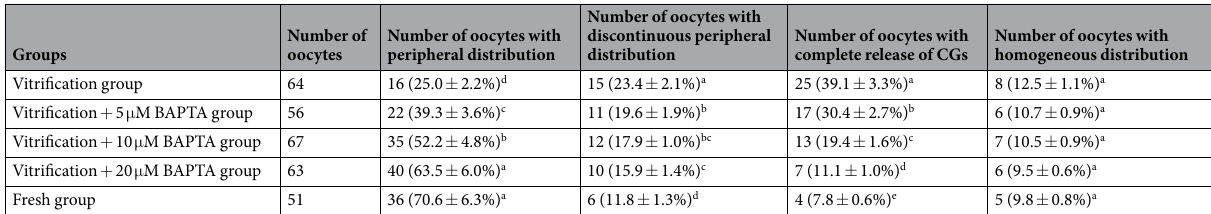
Table 1. Effect of BAPTA treatment on the CG distribution in vitrified bovine oocytes. a,b,c,d,e Values with different superscripts differ significantly within the same column ( P < 0.05).